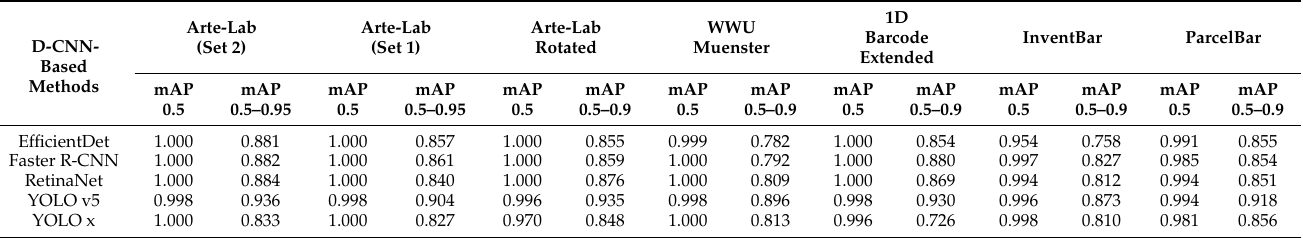
Table 6. The best barcode detection accuracy of different D-CNN methods applied over all bench- marked